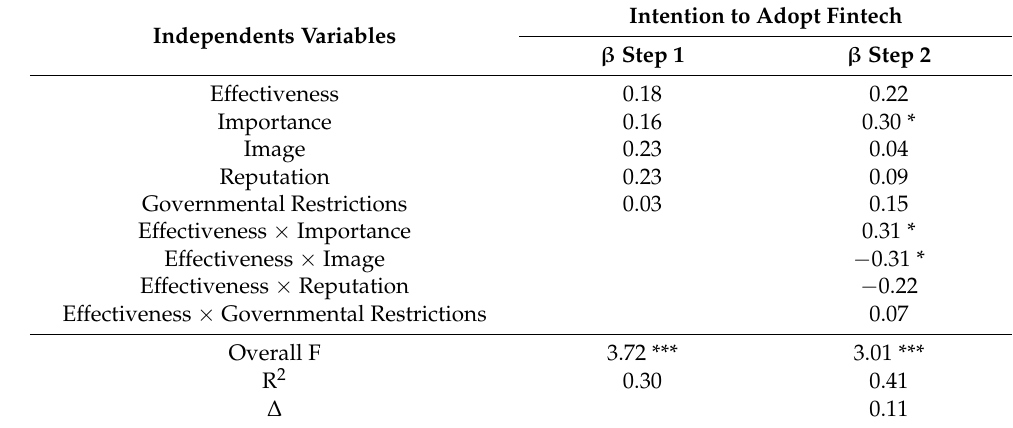
Table 8. Moderating effect of environmental context on the relationship between perceived effec- tiveness of Fintech services and intention to adopt Fintech services (Source—IBM SPSS Statistics